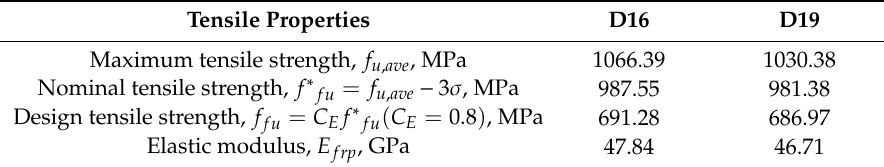
Table 2. Tensile properties of GFRP rebars.